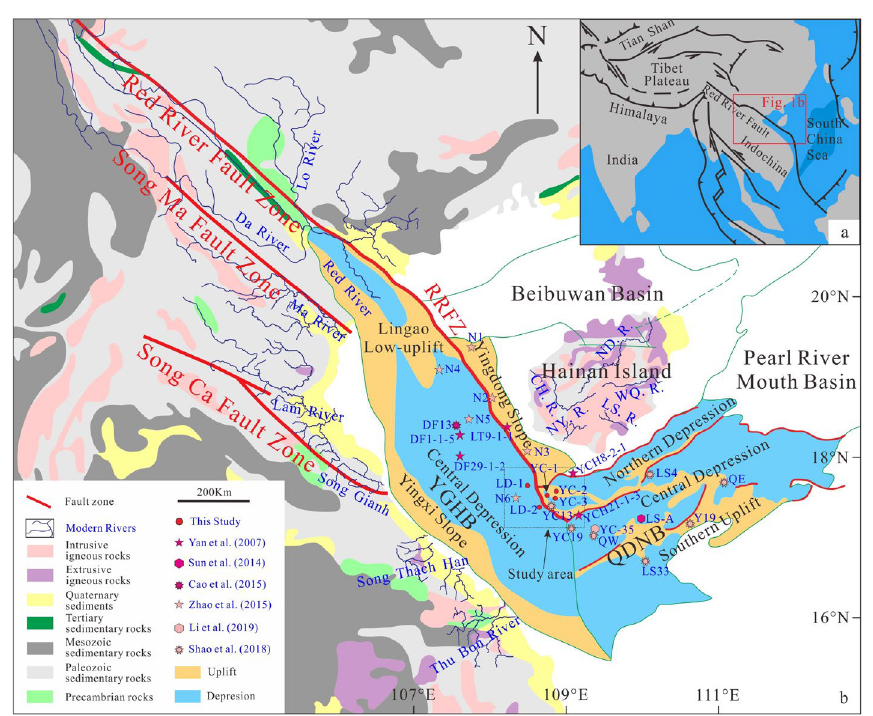
Figure 1. Map of tectonics and geology of Southeast Asia (modified from 7 ) show the location of Yinggehai and Qiongdongnan basins ( a ). Tectonic zones of the Yinggehai and Qiongdongnan basins (modified from 14 ) and the simplified geological map (modified from 8 ) of the potential source areas showing the lithological distribution along river cources ( b ). Major fault zones and major drainage system modified from 22 . YGHB-Yinggehai